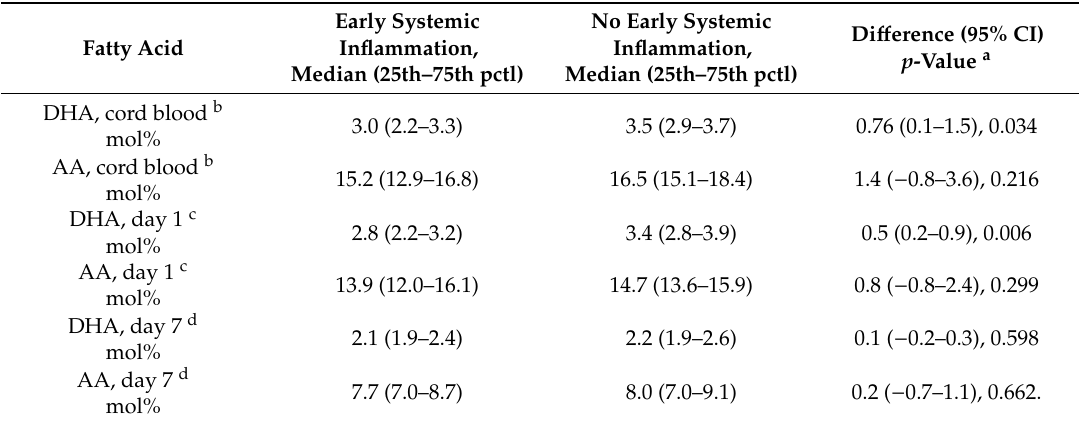
Table 2. Levels of docosahexaenoic acid (DHA) and arachidonic acid (AA) in cord blood, the first